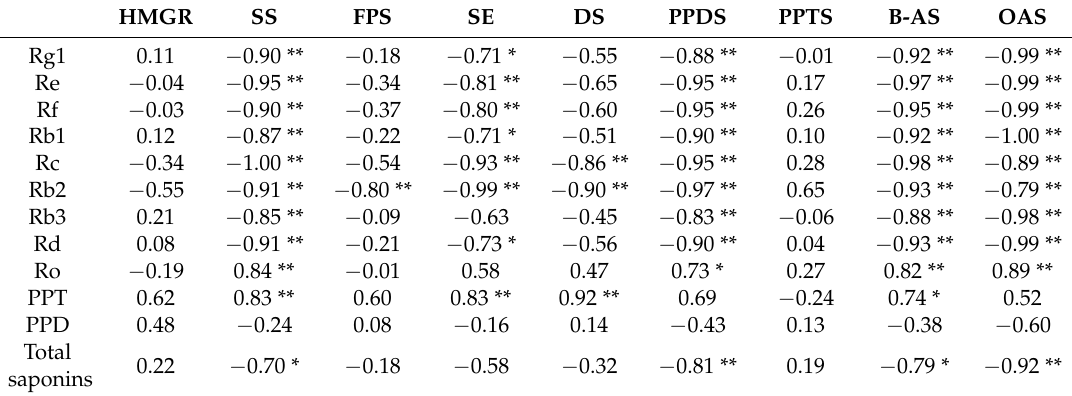
PPT 0.62 0.83 ** 0.60 0.83 ** 0.92 ** 0.69 − 0.24 0.52 PPD 0.48 − 0.24 0.08 − 0.16 0.14 − 0.43 0.13 − 0.38 − 0.60 Total 0.22 − 0.70 * − 0.18 − 0.58 − 0.32 − 0.81 ** 0.19 − 0.79 saponins